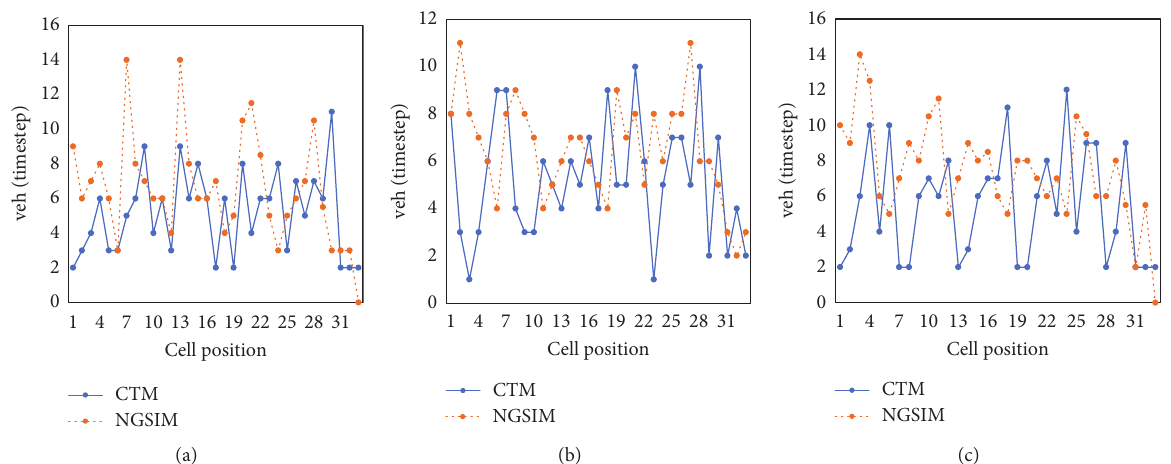
Figure 7: Case 4—comparison of the occupancies between CTM and US-101 at the (a) 50 th , (b) 100 th , and (c) 200 th time step.